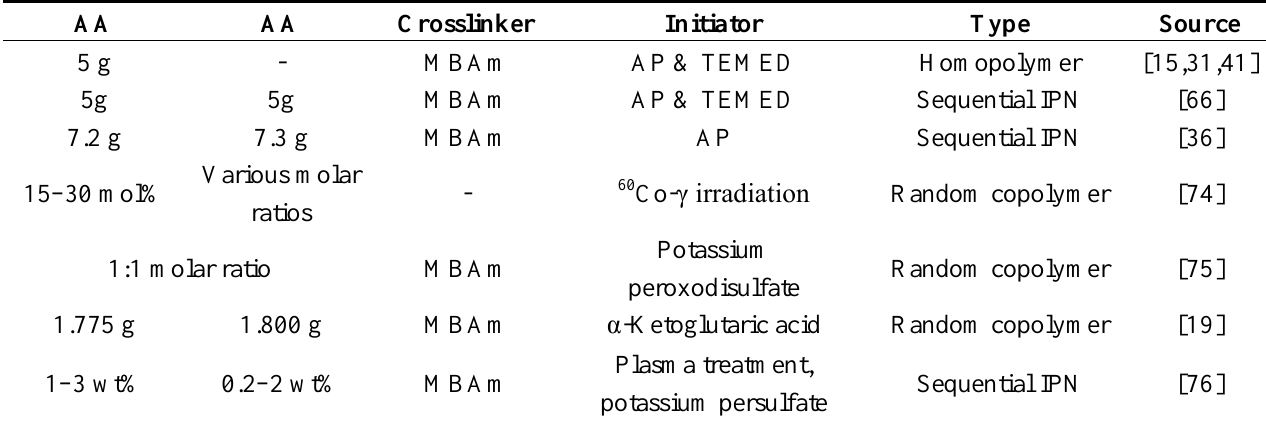
Table 1. Various recipes for Am-AA based